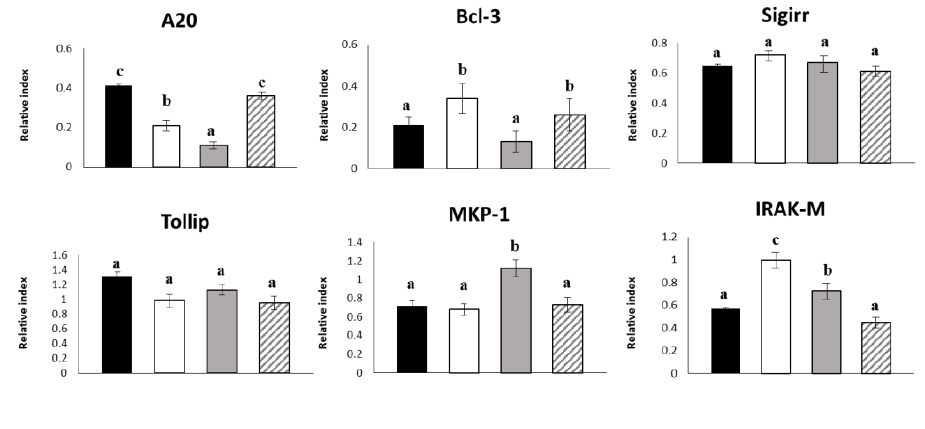
Figure 2. Effect of Lactiplantibacillus plantarum CRL681, CRL1506 or TL2677 on the expression of negative regulators of the Toll-like receptor (TLR) signaling pathway in porcine intestinal epithelial (PIE) cells. PIE cells were stimulated with CRL681, CRL1506 or TL2677 strains for 48 h. Untreated cells were used as controls. The expression of negative regulators of the TLR signaling pathway were studied at 48 h after lactobacilli stimulation (basal). The results represent three independent experiments. Results are expressed as mean ± SD. Bold letters indicate significant differences when compared to the control group ( p < 0.05).